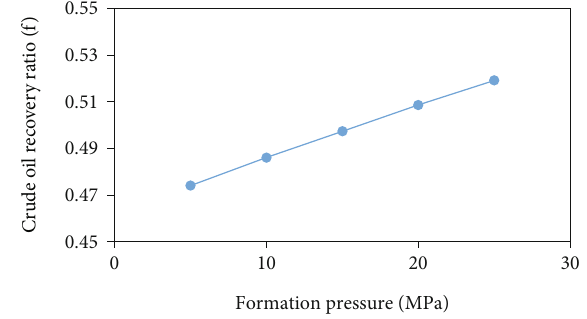
Figure 8: In fl uence of formation pressure on the crude oil recovery